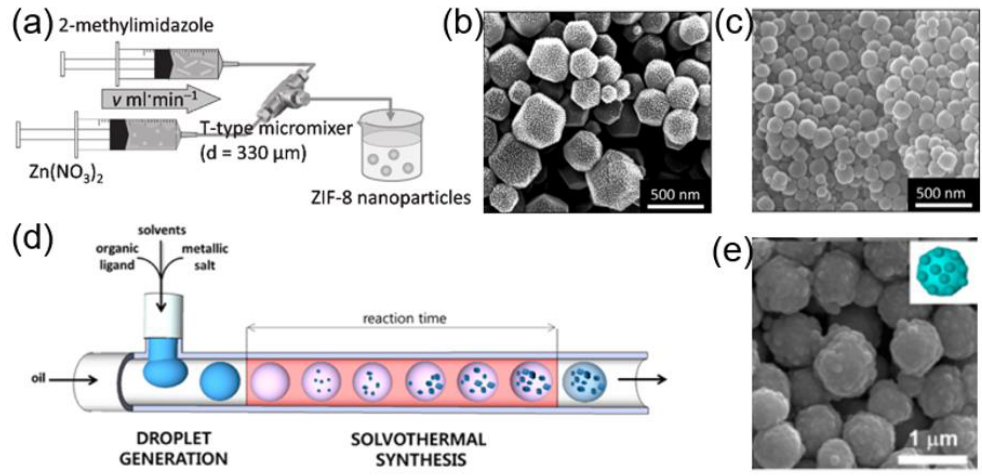
Figure 10. ( a ) Experimental setup for the synthesis of ZIF-8 nanoparticles by using a T-type micromixer.